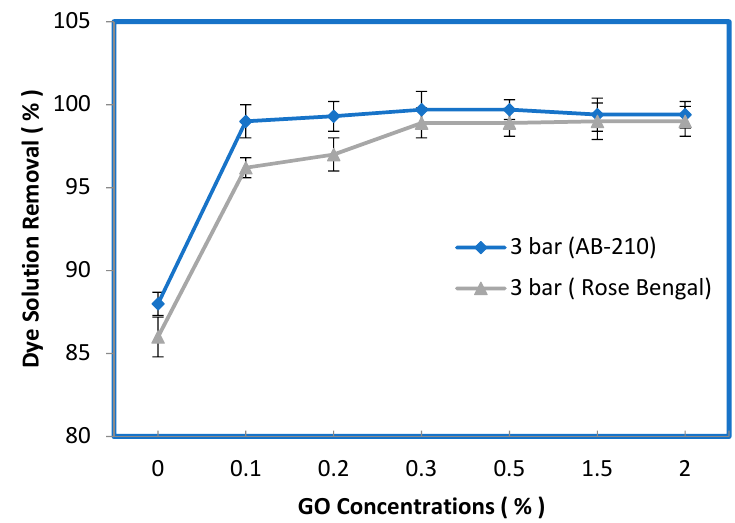
Figure 9. E ff ect of the dye concentration in feed solution on the dye removal e ffi ciency (R%) of the Figure 9. Effect of the dye concentration in feed solution on the dye removal efficiency (R%) of the membrane prepared at di ff erent GO membrane prepared at different GO concentrations.